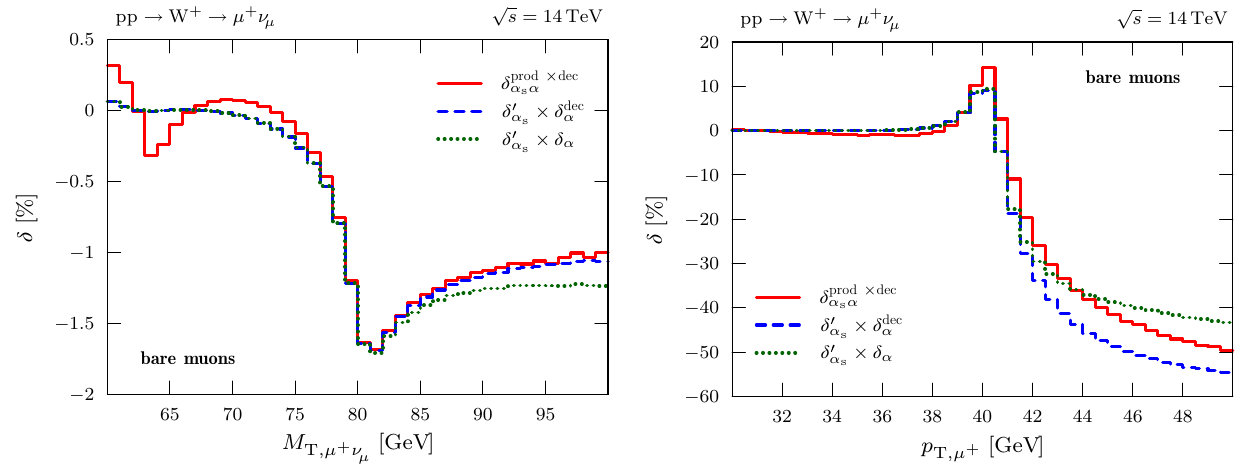
Fig. 36 Relative factorizable corrections (in red ) of O (αα s ) induced by initial-state QCD and final-state EW contributions to the transverse- mass distribution ( left ) and the transverse-lepton-momentum distribu-